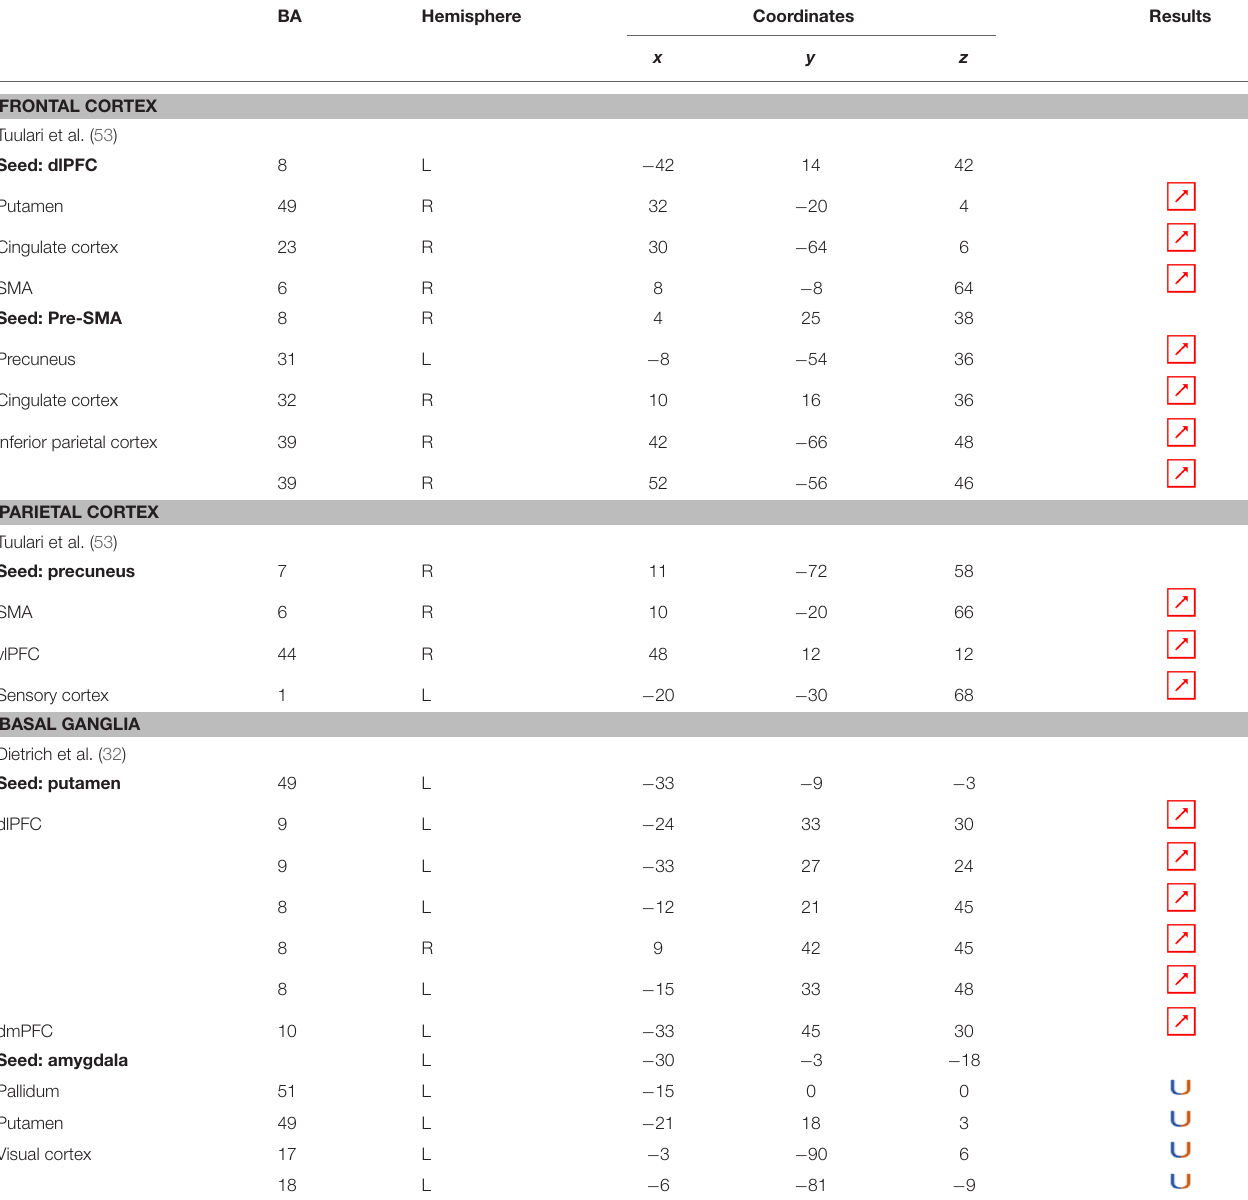
Red arrows indicate strengthened connectivity in obese in comparison with lean participants. U-shaped symbols indicate weaker neural connectivity in class I obese (BMI = 30) in comparison with lean participants, but stronger connectivity for obesity classes II and III (BMI = 35–40), reaching similar connection strengths as lean participants. BA, Brodmann area; dlPFC, dorsolateral prefrontal cortex; dmPFC, dorsomedial prefrontal cortex; pre-SMA, presupplementary area; SMA, supplementary area; vlPFC, ventrolateral prefrontal